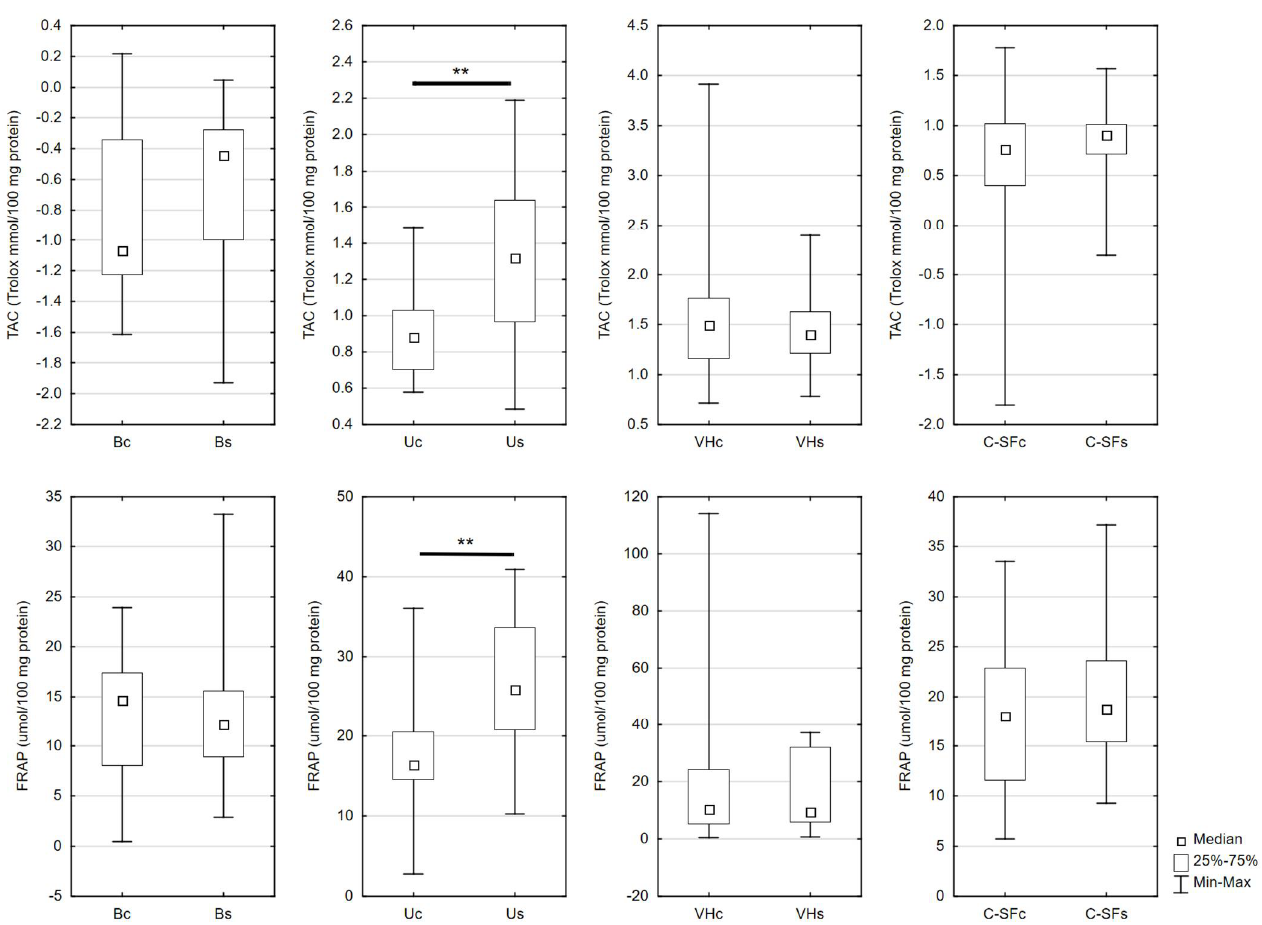
Figure 2. Redox status assays in the control and the study group in biological fluids. Bc, blood of the control group; Bs, blood of the study group; C-SFc, cerebrospinal fluid in the control group; C-SFs, cerebrospinal fluid in the study group; FRAP, ferric reducing ability of plasma level; TAC, total antioxidant capacity level; Uc, urine of the control group; Us, urine of the study group; VHc, vitreous humor of the control group; VHs, vitreous humor of the study group; ** p < 0.01 vs. control.